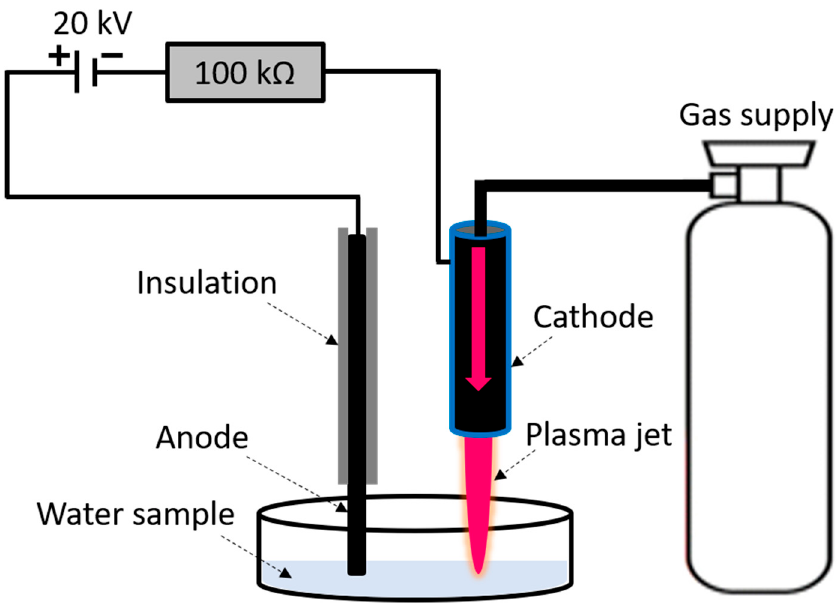
Figure 2. Atmospheric pressure DC plasma treatment system.